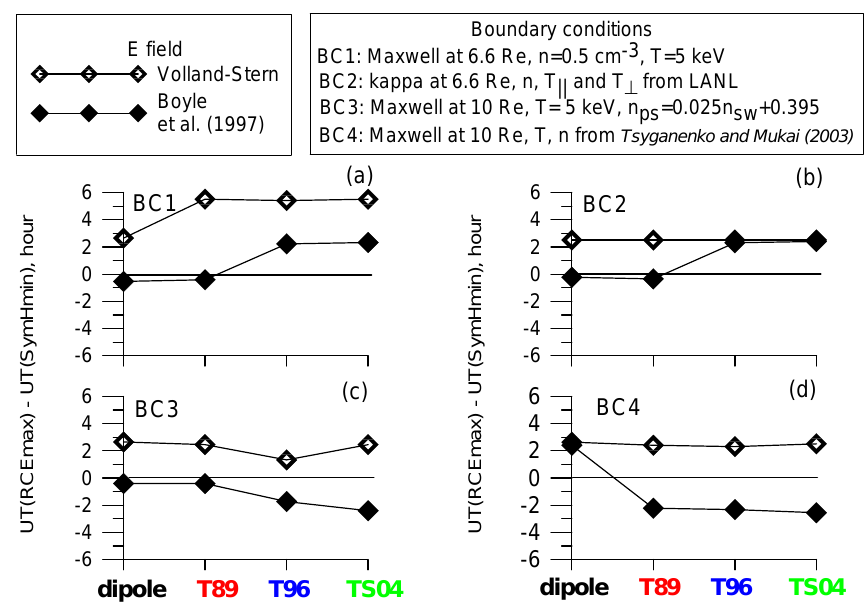
Fig. 6. Times of the peak magnitudes of the ring current energy profiles shown in Fig. 2 during 6–7 November 1997 storm in terms of the difference 1 UT RCE =UT ( RCE max ) − UT ( SymH min ) (see the text).